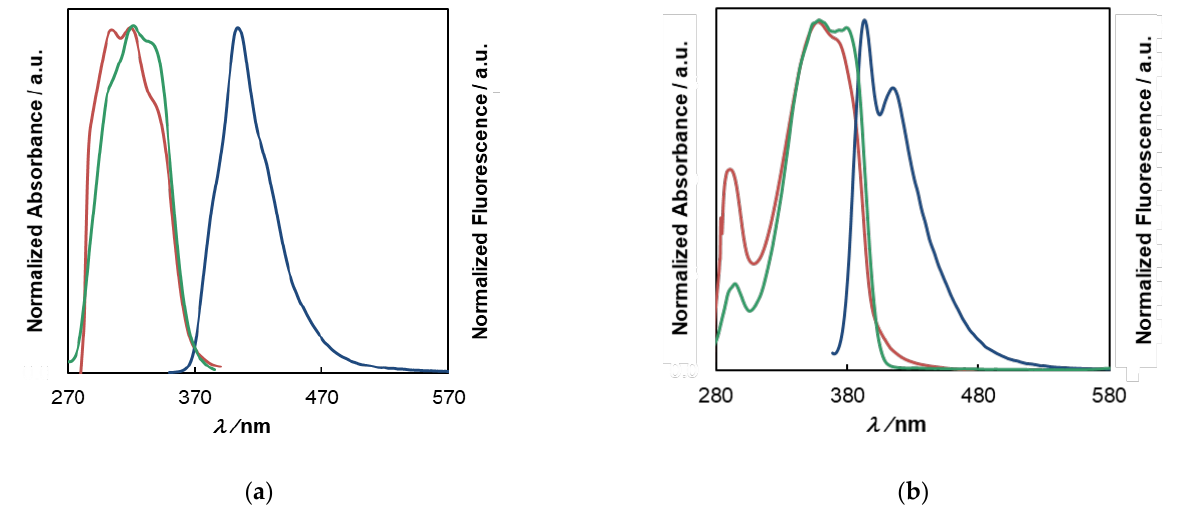
Figure 1. Absorption (red line), excitation (green line, monitored at emission maxima), and emission (blue line) spectra ( λ exc = 357 nm, toluene) of compounds 4 ( a ) and 5 ( b